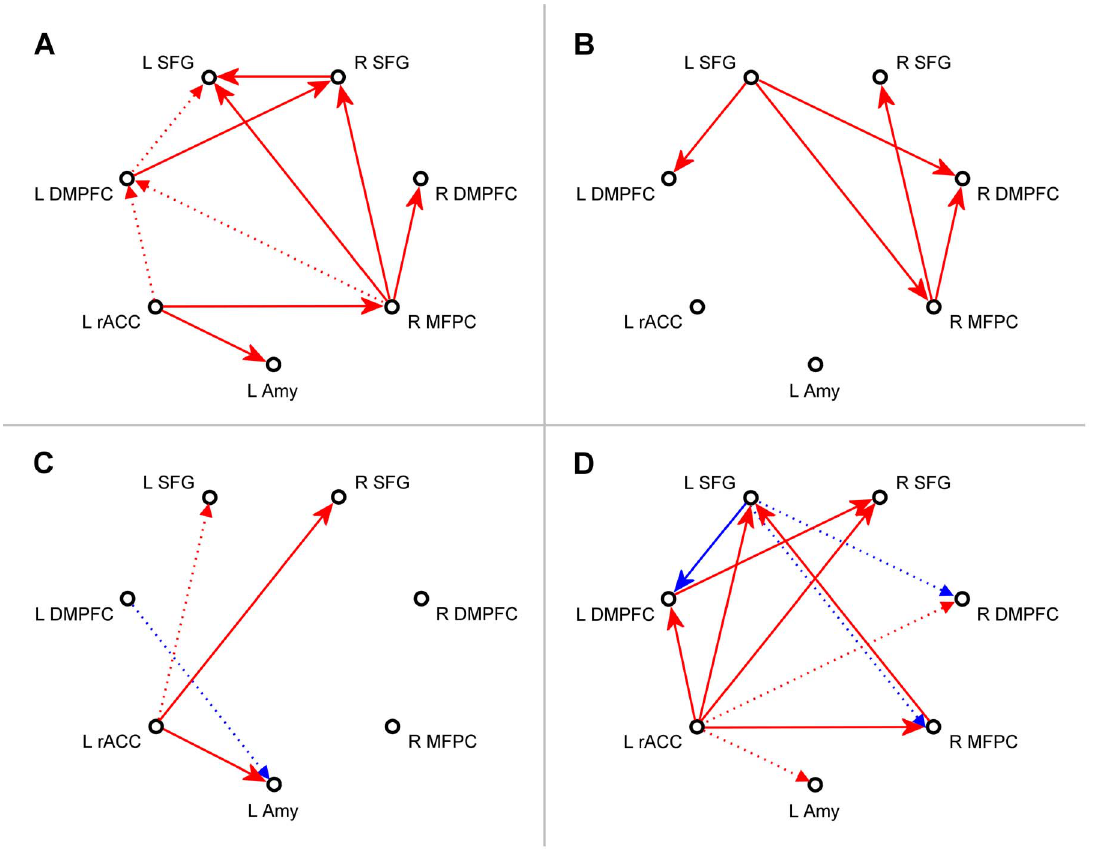
Figure 3 . Interactions within the network suggested by the multivariate VAR analysis. Results of the multivariate first-order vector autoregression (VAR) analysis for the network of seven ROIs depicted in Fig. 1. The four subplots show meta-analytic group statistics for path coefficients for the following groups and contrasts. (A) Experimental group (EG), neurofeedback Run 3. (B) Control group (CG), Run 3. (C) Difference between Run 3 and Rest for EG. (D) Difference between Run 3 for EG and Run 3 for CG. Red arrows denote augmentation effects (path coefficient a . 0), and blue arrows – inhibition effects (path coefficient a , 0). In (A) and (B), solid arrows correspond to effects with FDR q , 0.05, and dotted arrows – to effects with 0.05 # q , 0.1. In (C) and (D), solid arrows correspond to results with uncorrected P , 0.05, and dotted arrows – to results with 0.05 # P , 0.1.